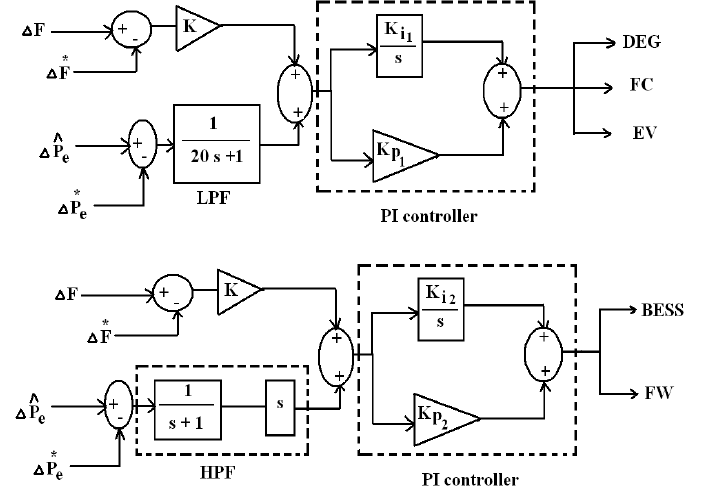
Figure 4. PI controllers scheme. DEG: diesel engine